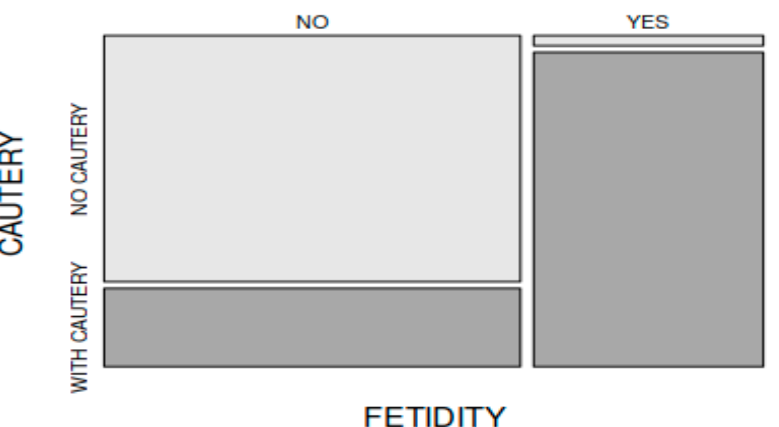
Figure 3. Incidence of postoperative fetidity occurrence (halitosis) was significantly higher in group A patients (electrocautery group). In comparing the frequency of postoperative ear pain encountered in the patients from group A (6 out of 45 patients) to that of the patients in group B (4 out of 45 patients), the difference between the groups was not statistically significant (X-squared = 0.112, df = 1, p = 0.737) (Figure